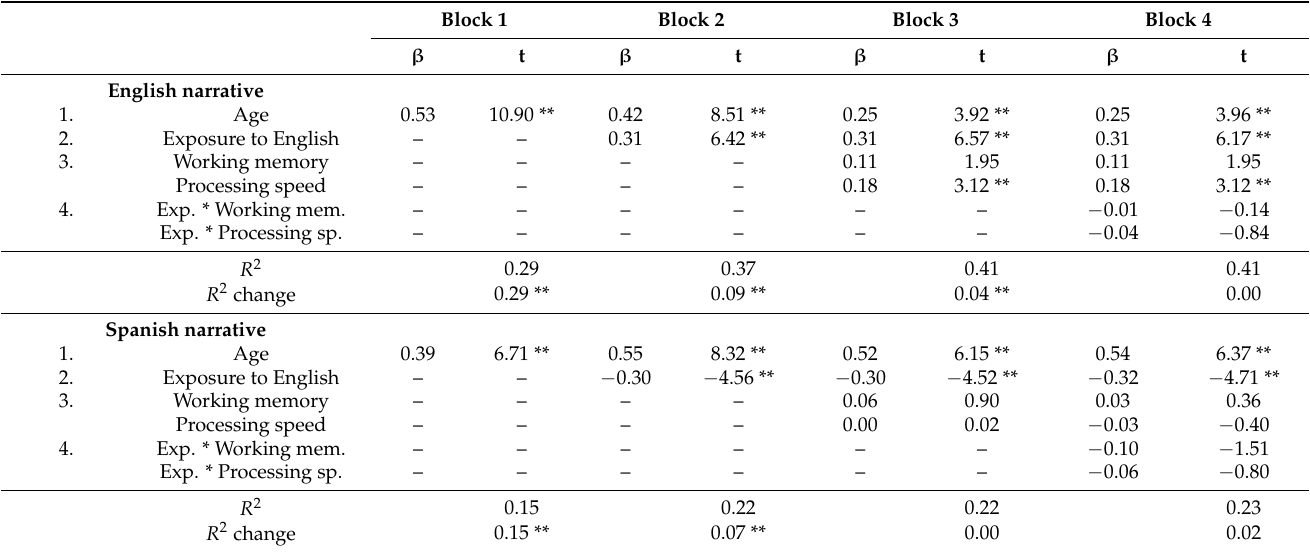
Table 5. Model summaries of regressions predicting morphosyntax using narrative